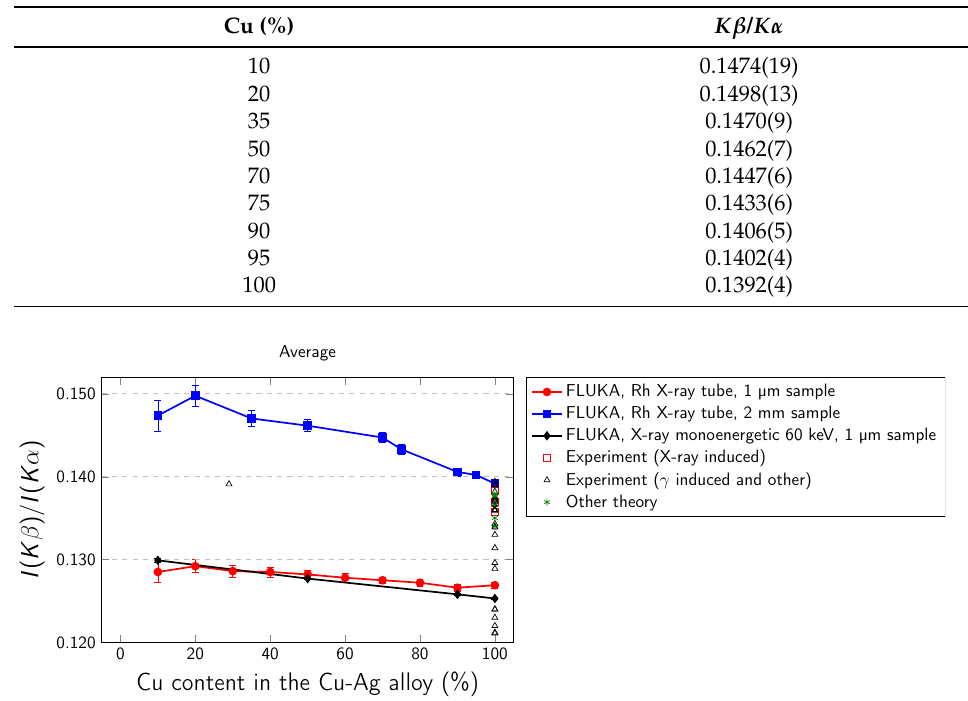
Table 3. Simulated K β / K α intensity ratio for 2 mm thick samples induced by Rh X-ray tube radiation. Only backward direction is calculated.